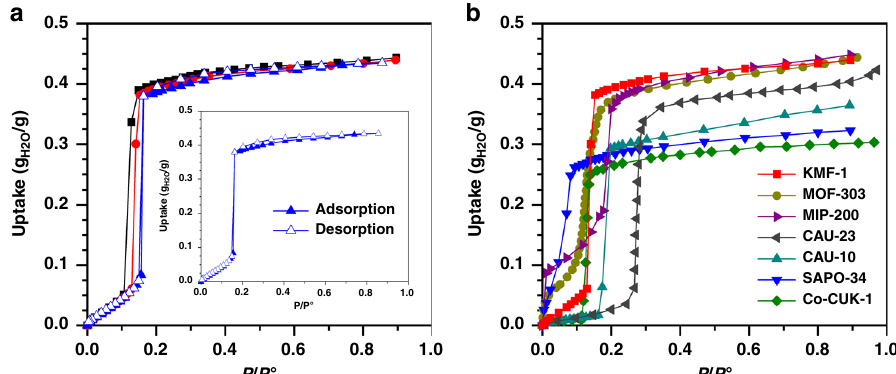
Fig. 2 Water-sorption isotherms for KMF-1 and benchmark adsorbents. a Experimental water-adsorption isotherms for KMF-1 collected at three different temperatures: 20 °C ( ■ ), 30 °C ( ● ), and 40 °C ( ▲ ). Insert shows the adsorption/desorption isotherms at 40 o C. b Comparison of water-adsorption isotherms for KMF-1 ( ■ ) and benchmark adsorbents: MOF-303 ( ● ) 40 , CAU-10 ( ▲ ) 4 , SAPO-34 ( ▼ ) 4 , MIP-200 ( ▶ ) 14 , Co-CUK-1( ◆ ) 11 at 30 °C, and CAU-23 ( ◀ ) 31 at 25 °C.